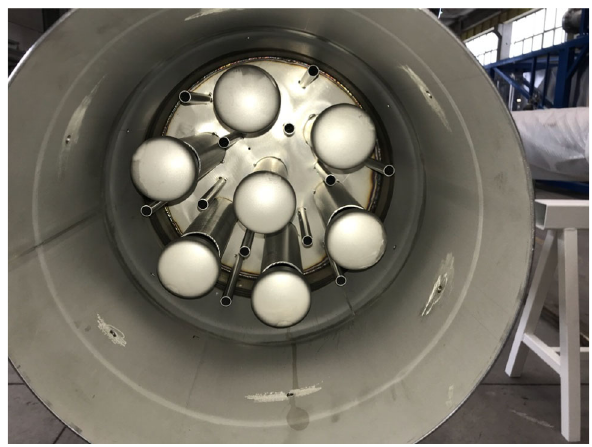
Fig. 7 A view from above of a liquid distributor. The small pipes with- out a top cap are perforated on the side, allowing the liquid to flow down to the column section below. The wider pipes with the top cap are the chimneys allowing the vapor to rise from the column section below